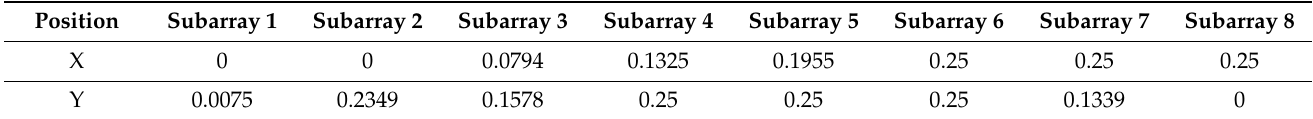
Figure 3. Sparse antenna array designed with eight regular subarrays. Table 1. The position of eight subarrays.